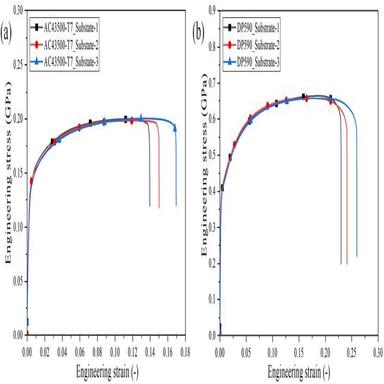
Engineering stress–strain curves for (a) AC43500-T7_Substrate and (b) DP590_Substrate.